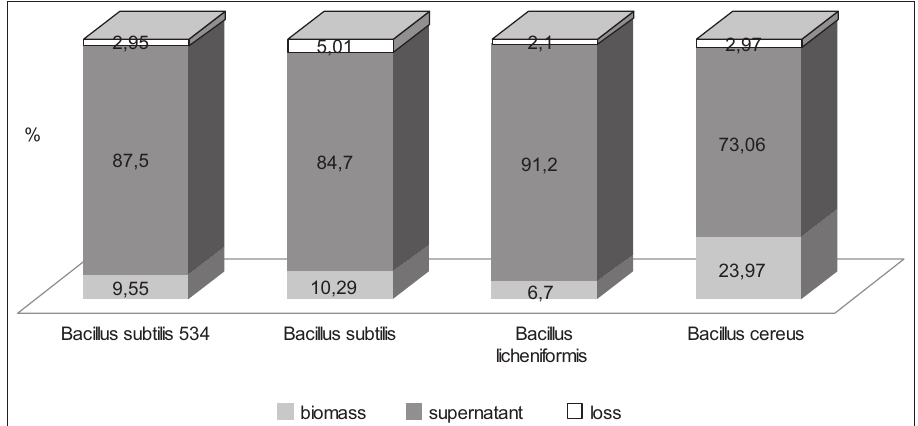
Figure-2: Evaluation of the bioaccumulating property of probiotic